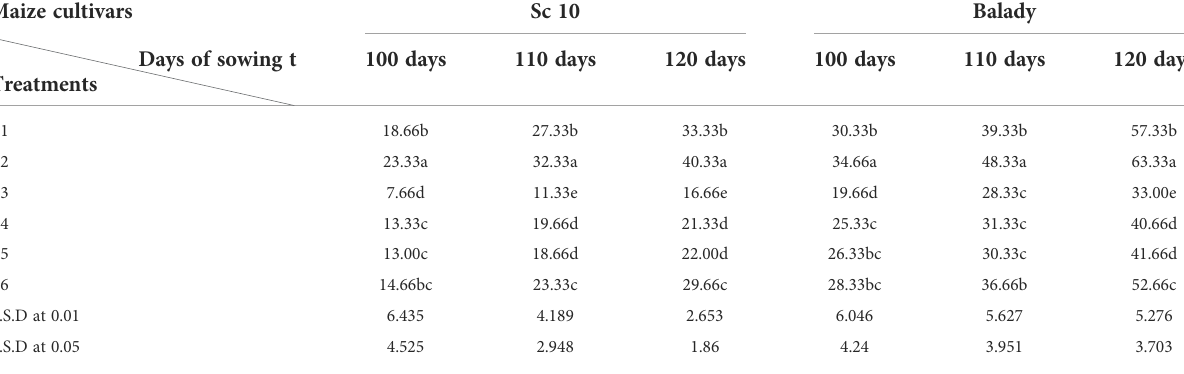
TABLE 8 Fusarium verticillioides frequency % from kernels under different soil treatments at different times after sowing during the 2020 growing season. Maize cultivars Sc 10 Balady Days of sowing